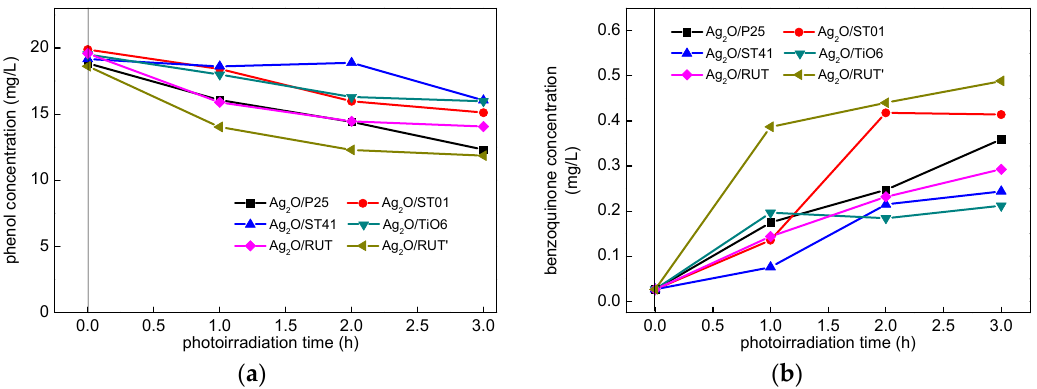
Figure 9. Change in phenol ( a ) and benzoquinone ( b ) concentrations during vis irradiation ( λ > 400 nm) of Ag 2 O/TiO 2 photocatalysts.